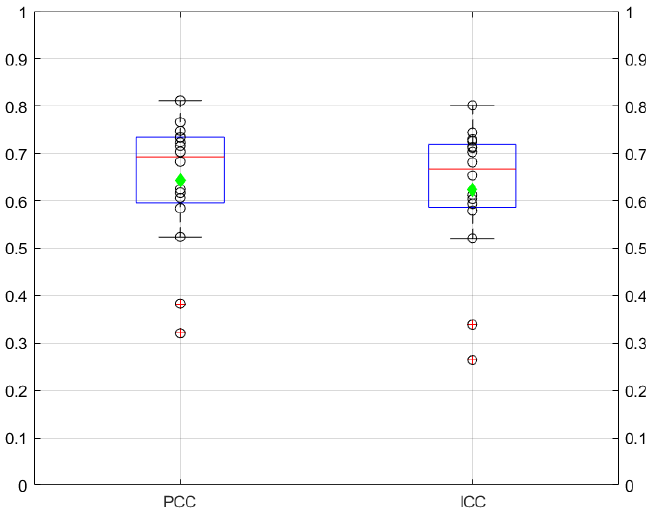
Figure 4. Boxplot of the voxelwise PCC and ICC between the SPECT-MAA and PET-MS based ADD computed on the liver reference volume of each patient. The two green diamonds correspond to the mean. The circles containing red plus sign are considered/taken as outliers.